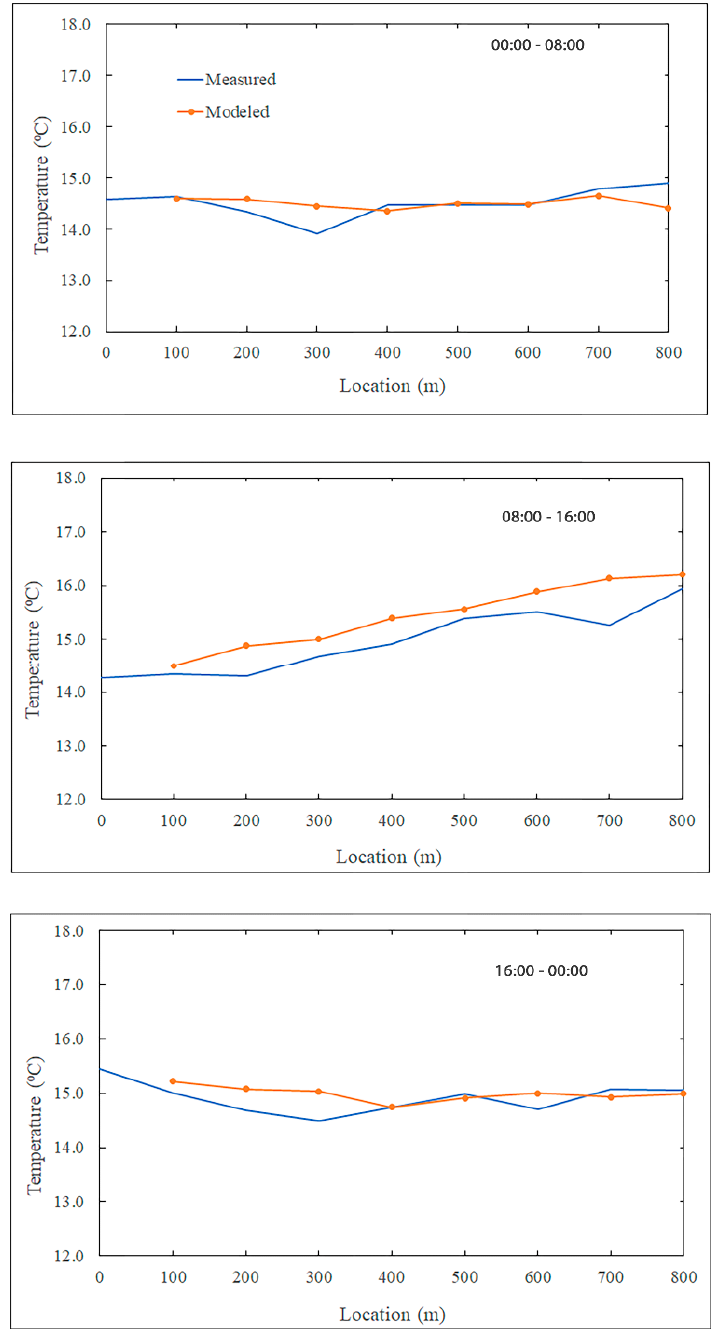
Figure 4. Lagrangian plots for Little Creek comparing observed and heat-budget-modeled temperatures for three 8 h time periods on 24 August 2014 as water traveled downstream from locations 0 to 800 m.